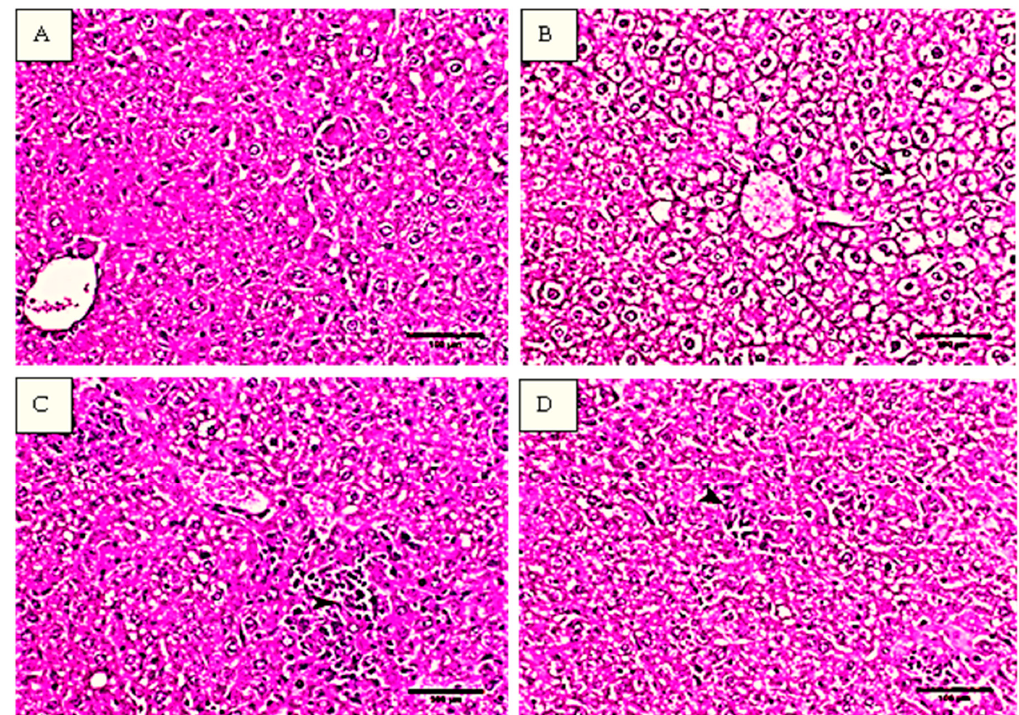
Figure 2. Histopathological graphs of liver sections stained by hematoxylin and eosin (H&E). ( A ): control group, showing normal hepatocytes with oval cytoplasm and with vesicular-shaped nucleus. ( B ): CCl 4 model group, arrowhead presented multifocal granuloma like lesions. ( C ): CCl 4 + flavone (10 mg / kg) group, illustrated marked decrease the number of focal infiltrative areas and with remarkable decrease the number of neoplastic cells (arrowhead). ( D ): CCl 4 + flavone (25 mg / kg) group, arrowhead revealed decrease hepatic degeneration, mild degree of cell swelling, and small number of mononuclear inflammatory cells. Scale bar = 100 µ m.